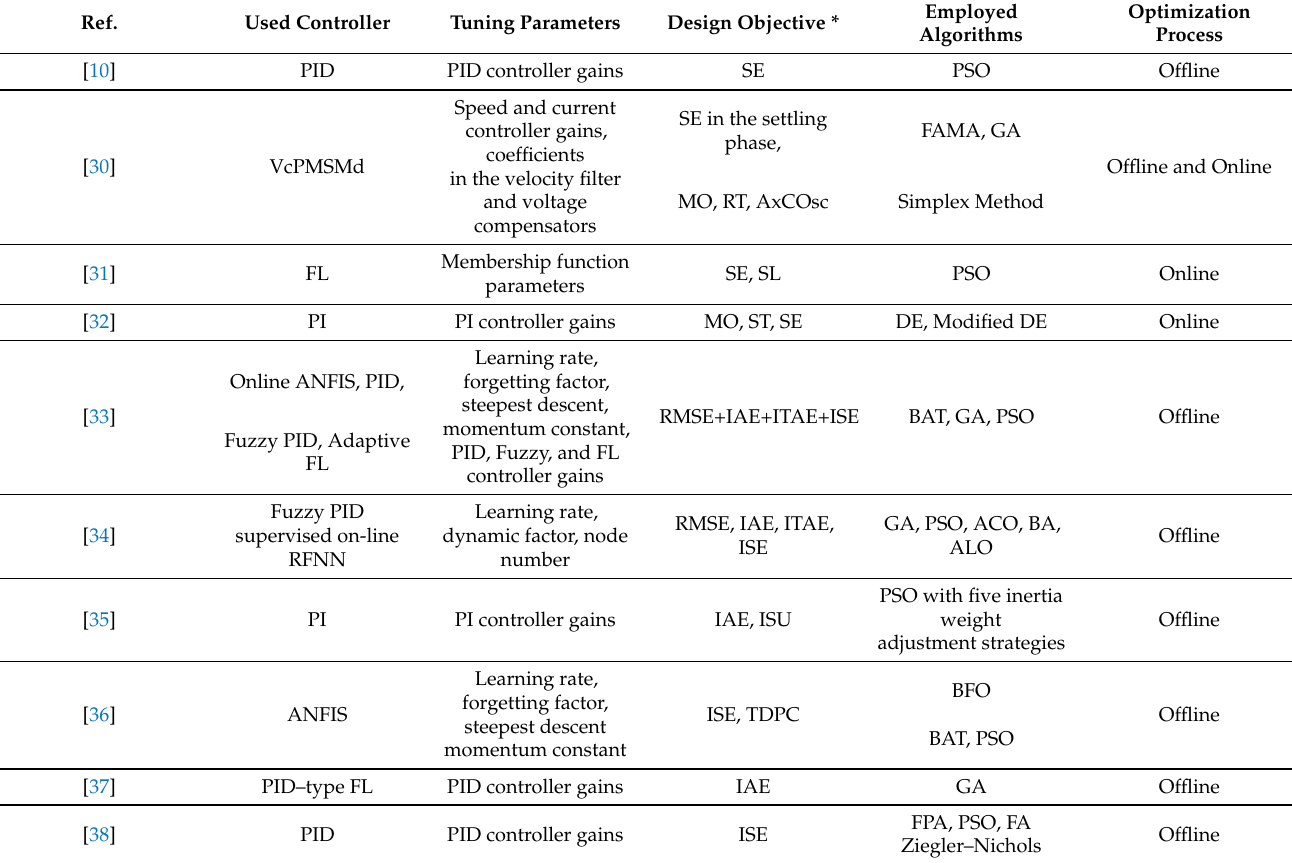
Table 1. Investigations related to the BLDC motor controller tuning problem using metaheuristic al-